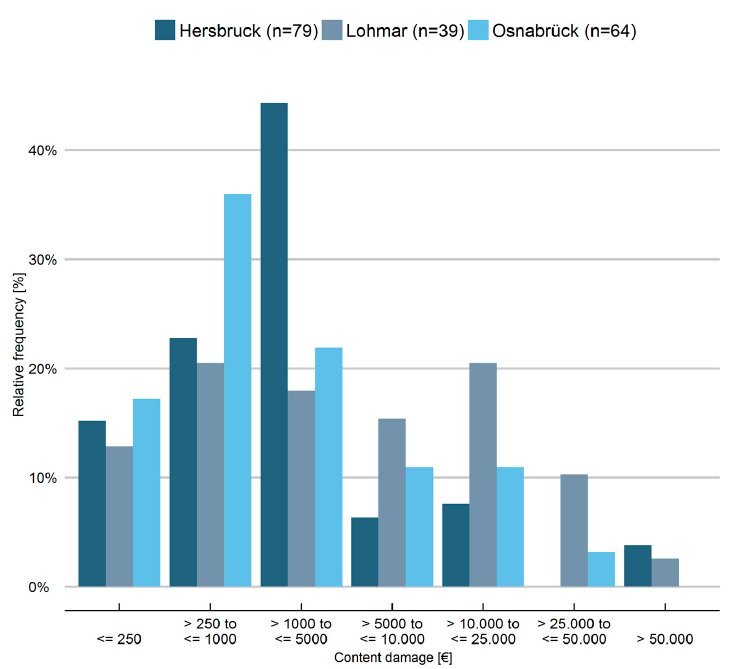
Figure 8. Distribution of classified content damage by study area based on inflation adjusted values.